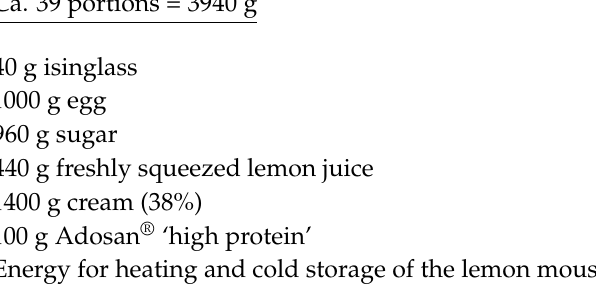
Procedure: Whip a whole egg with sugar for a thick eggnog in a large pot, possibly over 2–3 batches with max. 6 eggs at a time. Whip the cream until stiff and add Adosan ® . Hydrate the isinglass in cold water for 10 min, squeeze out excess water, heat and then cool to below 4 ◦ C before adding it gradually to the eggnog through a sieve while stirring. Carefully add whipped cream, while the mousse is complete by adding lemon juice until the taste is